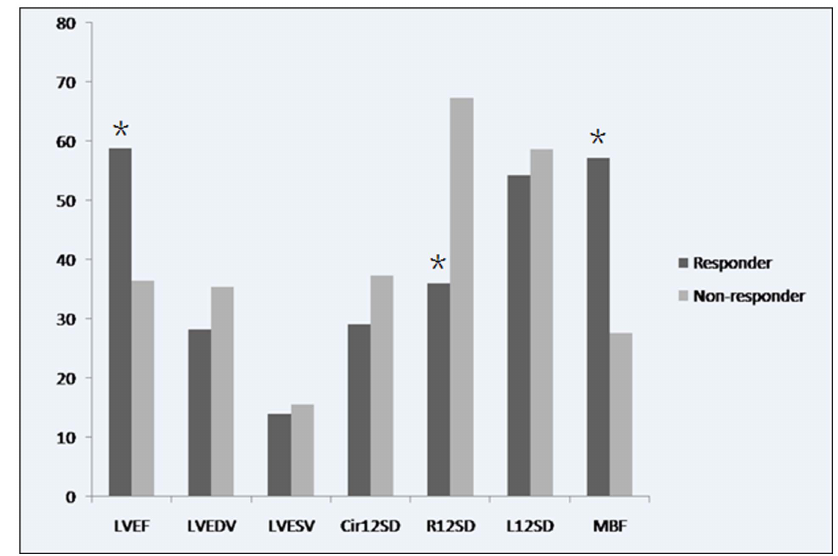
Figure 3. An illustration of LVEF, LVEDV, LVESV, Cir12SD, R12SD, L12SD, and MBF between response group and non-response group. The MBF was significantly improved in response group. LVEF 5 left ventricular ejection fraction; LVEDV 5 left ventricular end diastolic volume; LVESV 5 left ventricular end systolic volume; Cir12SD 5 standard deviation of the time-to-peak of the transmural regional circumferential strain; R12SD 5 standard deviation of the time-to-peak of the transmural regional radial strain; L12SD 5 standard deviation of the time-to-peak of the transmural regional longitudinal strain; MBF 5 myocardial blood flow.